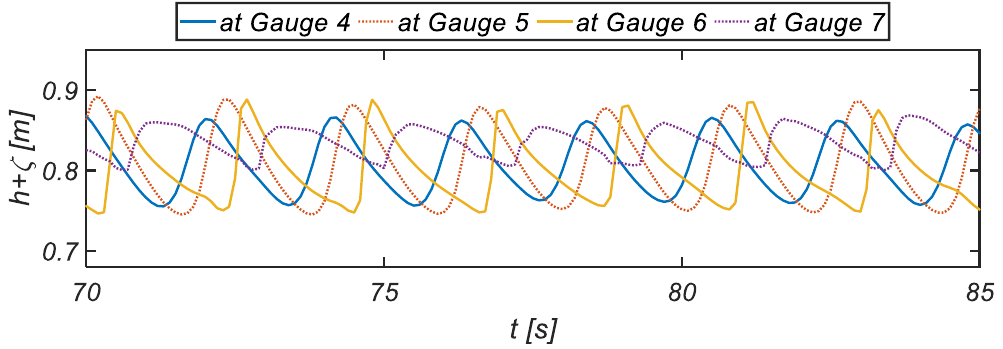
Figure 6. Sampled time series of numerically simulated free surface elevation at varying stages of shoaling process.